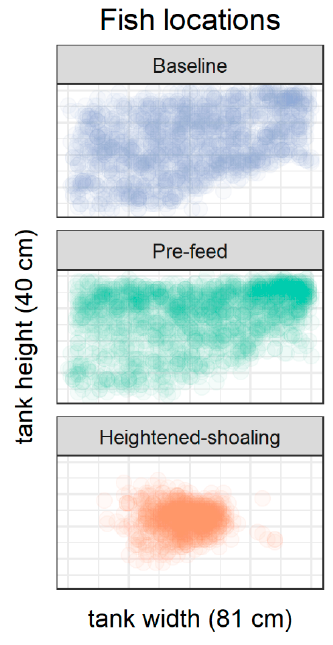
Figure 2. Location of each fish by period type. The X-Y coordinates as viewed from the side of a tank (to-scale, not including the inaccessible area, n = 6 tanks; 10 fish per tank). The location of each fish was collected from a snapshot taken every 10 s during the 100 s video clips (18 baseline clips, 18 pre-feed clips, 9 heightened-shoaling clips; 45 clips, 450 snapshots in all). Fish were higher in the water column pre-feed than the other two periods (baseline: p < 0.001; shoaling; p < 0.001), but otherwise their average location in the tank was indistinguishable across observation periods ( p > 0.1). The absence of observed fish locations in the bottom right corner of each panel is explained by the presence of the gravel slope that angled up from the bottom middle of the tank to about halfway up the right side of the tank. Note also that the heightened shoaling episodes occurred at the center of the tank and in the middle of the slope.